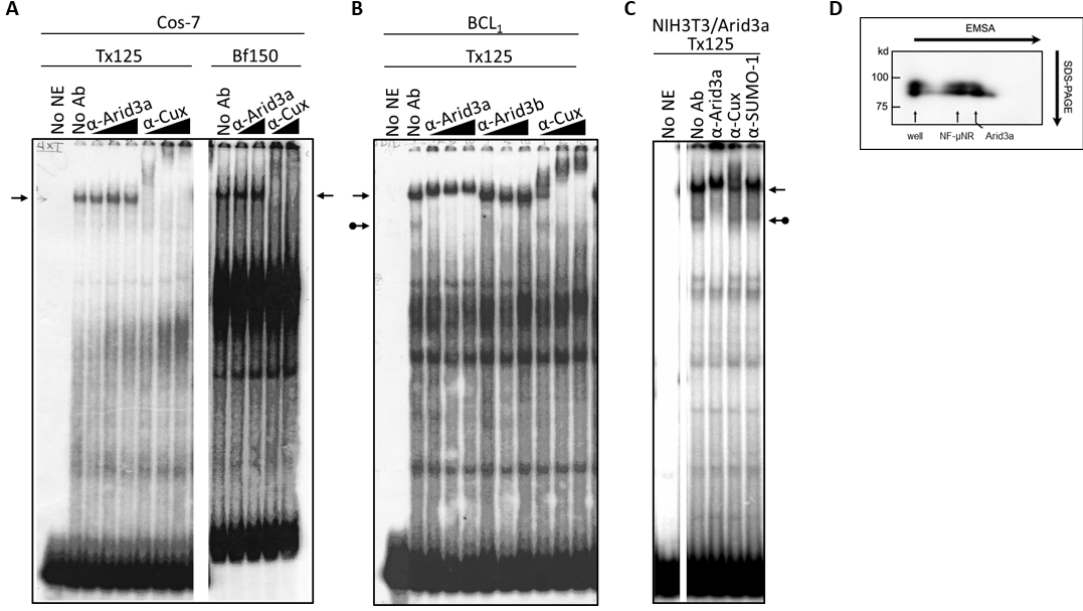
Figure 4. The NF- µ NR complex contains Arid3a in B cells but not in non-B cells that were tested. ( A ) NF- µ NR in Cos-7 includes CDP/Cux but not Arid3a. Extract and probe preparation, EMSA and supershifts were performed as in Figure 3. Triangles indicate increasing concentration of indicated antibodies. Arrows denote mobility of the NF- µ NR complex; ( B ) Anti-Arid3a antiserum super-shifted the NF- µ NR complex (plain arrows) as well as the Arid3a complex (arrows with balls) in BCL 1 ; ( C ) The NF- µ NR complex in NIH3T3 cells (NIH3T3-Arid3a) stably expressing Arid3a via retroviral infection; ( D ) Confirmation of Arid3a within both NF- µ NR and Arid3a EMSA complexes by 2-D gel electrophoresis in B cells. First dimension, standard EMSA of nuclear extract prepared from M12.4. Second dimension, SDS-PAGE, was followed by Western blotting with anti-Arid3a. Positions of the two EMSA complexes are indicated by arrows. Molecular markers are shown on the right of the gel.